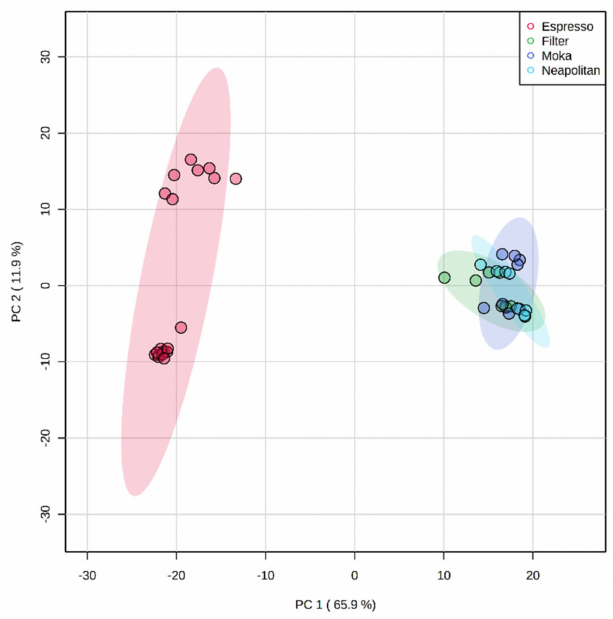
Figure 2. Principal Component Analysis (PCA) score plot for the different coffee samples included in the different extraction category (i.e., Espresso, Filter, Moka, and Neapolitan). Thereafter, to better investigate the compounds or classes of compounds explaining most of the variability observed, the following supervised multivariate statistical approach, namely OPLS-DA, was used. The OPLS-DA score plot is reported in Figure 3. The goodness model parameters were highly significant, being: correlation R 2 Y (cum) = 0.772, R 2 X = 0.762, and Q 2 Y prediction ability = 0.616. Also, the prediction model was cross-validated using a Cross Validation-ANOVA ( p -value = 2.15 × 10 − 14 ) and both strong outliers and overfitting could be excluded (Supplementary File S1). Besides, Figure 3 indicates that the orthogonal components were effective in separating the Espresso vs. the other extraction methods, while the chemical distance between coffee samples included in the Filter, Moka, and Neapolitan groups was